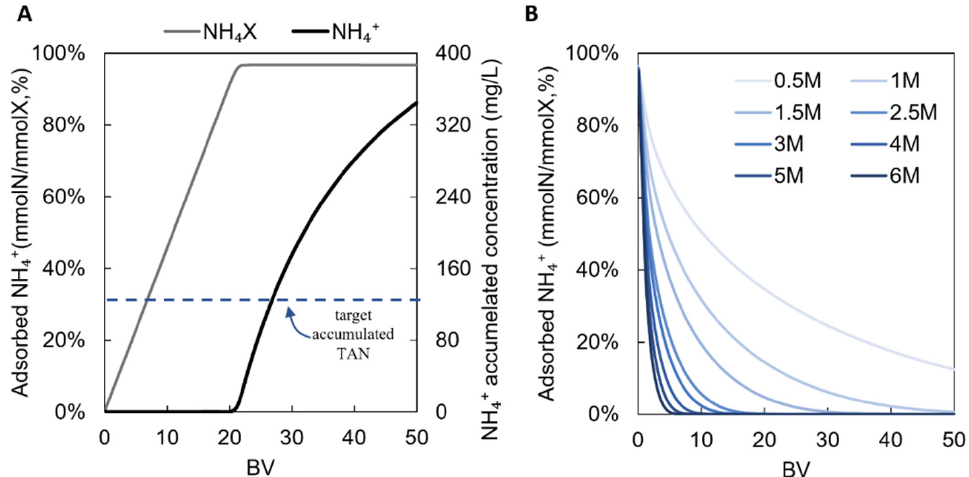
Figure 5. ( A ) Cumulative TAN concentration in the CIX step effluent and the percentage of used adsorption sites of the simulated column; ( B ) percentage of desorbed TAN of a pre-loaded column using various NaCl concentrations. All simulations were done with the PHREEQC software Transport function, database = phreeqc.dat.